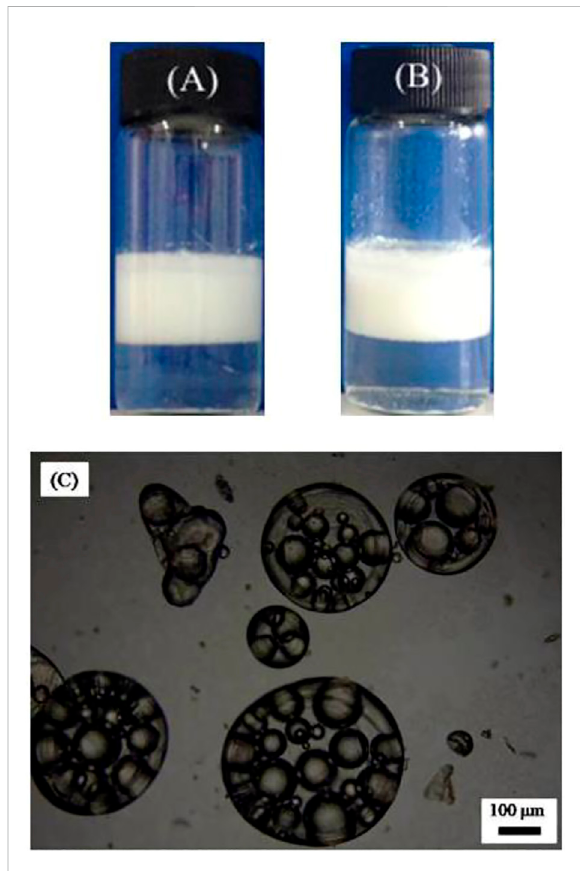
FIGURE 8 Appearance of the water-in-toluene-in-water multiple emulsion, taken (A) 1 day, (B) 1 week after preparation, and (C) optical micrograph recorded 24 h after preparation. The inner W/ O emulsion is stabilized by 1.0 wt% CaCO 3 nanoparticles and 3 × 10 − 3 mol/L SDS, and the outer O/W emulsion is stabilized by 1.0 wt% CaCO 3 nanoparticles and 3 × 10 − 4 mol/L SDS. Volume ratio of inner W/O emulsion to the outer water phase = 2:1.